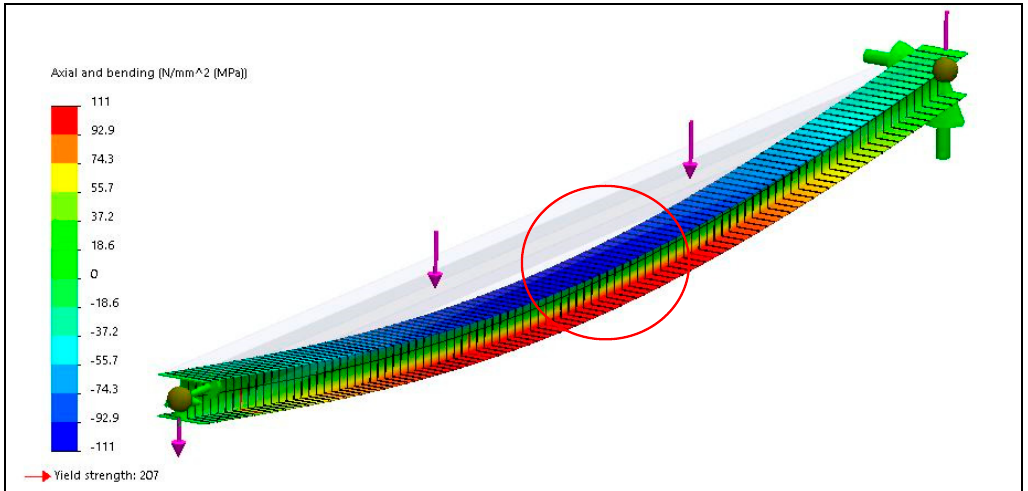
Figure 18. Stress analysis on the beam.